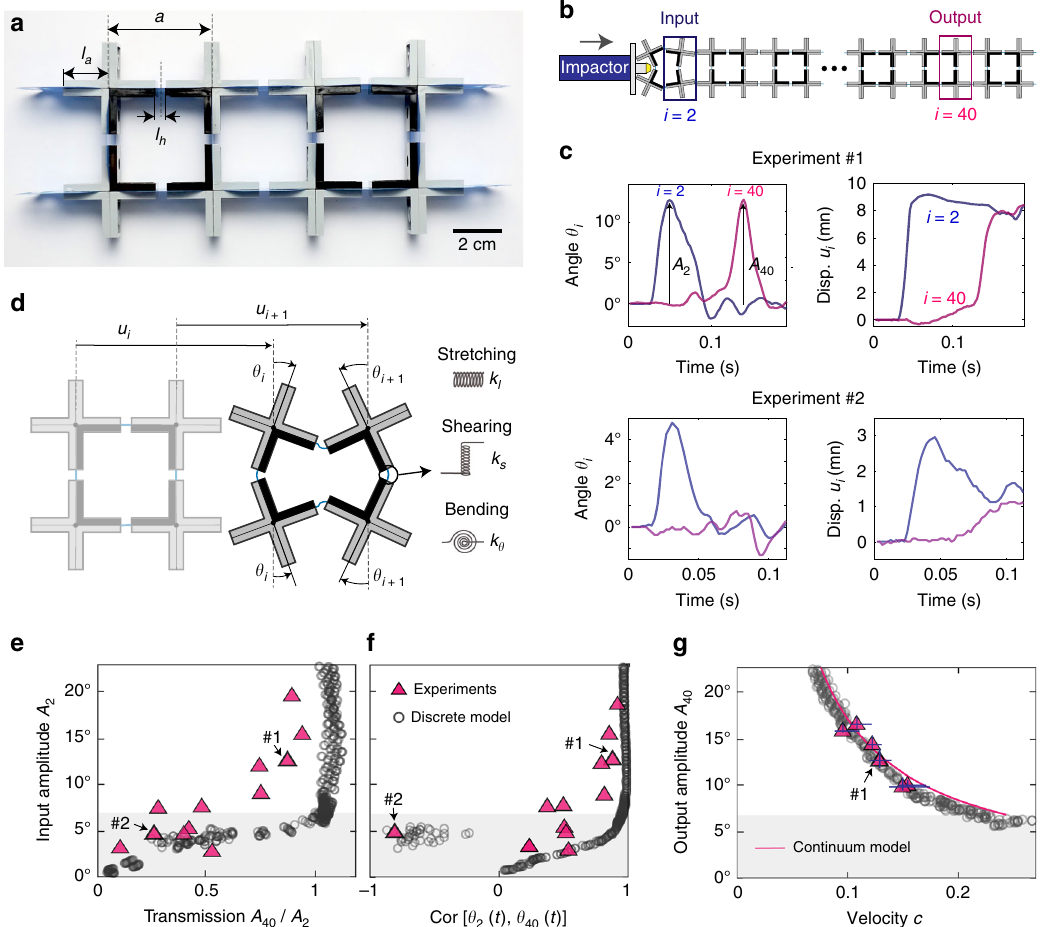
Fig. 1 Propagation of elastic vector solitons in a chain with all horizontal hinges aligned. a Few units of our sample (Scale bar: 2 cm). b Schematics of our testing setup. c Evolution of the rotation and longitudinal displacement of the second and fortieth units as a function of time during two different experiments. d Schematic of the system. e Measured transmission, A 40 / A 2 , as a function of the amplitude of the input signal, A 2 . f Measured cross- correlation of θ 2 ( t ) and θ 40 ( t ) as a function of the amplitude of the input signal, A 2 . g Evolution of the pulse velocity c as a function of its amplitude. The gray region in e – g highlights the amplitude gap as predicted by the continuum model. The error bars in g show the 95% con fi dent interval of the measured velocities and amplitudes of solitons in experiments. The corresponding error bars for simulation results are too small to